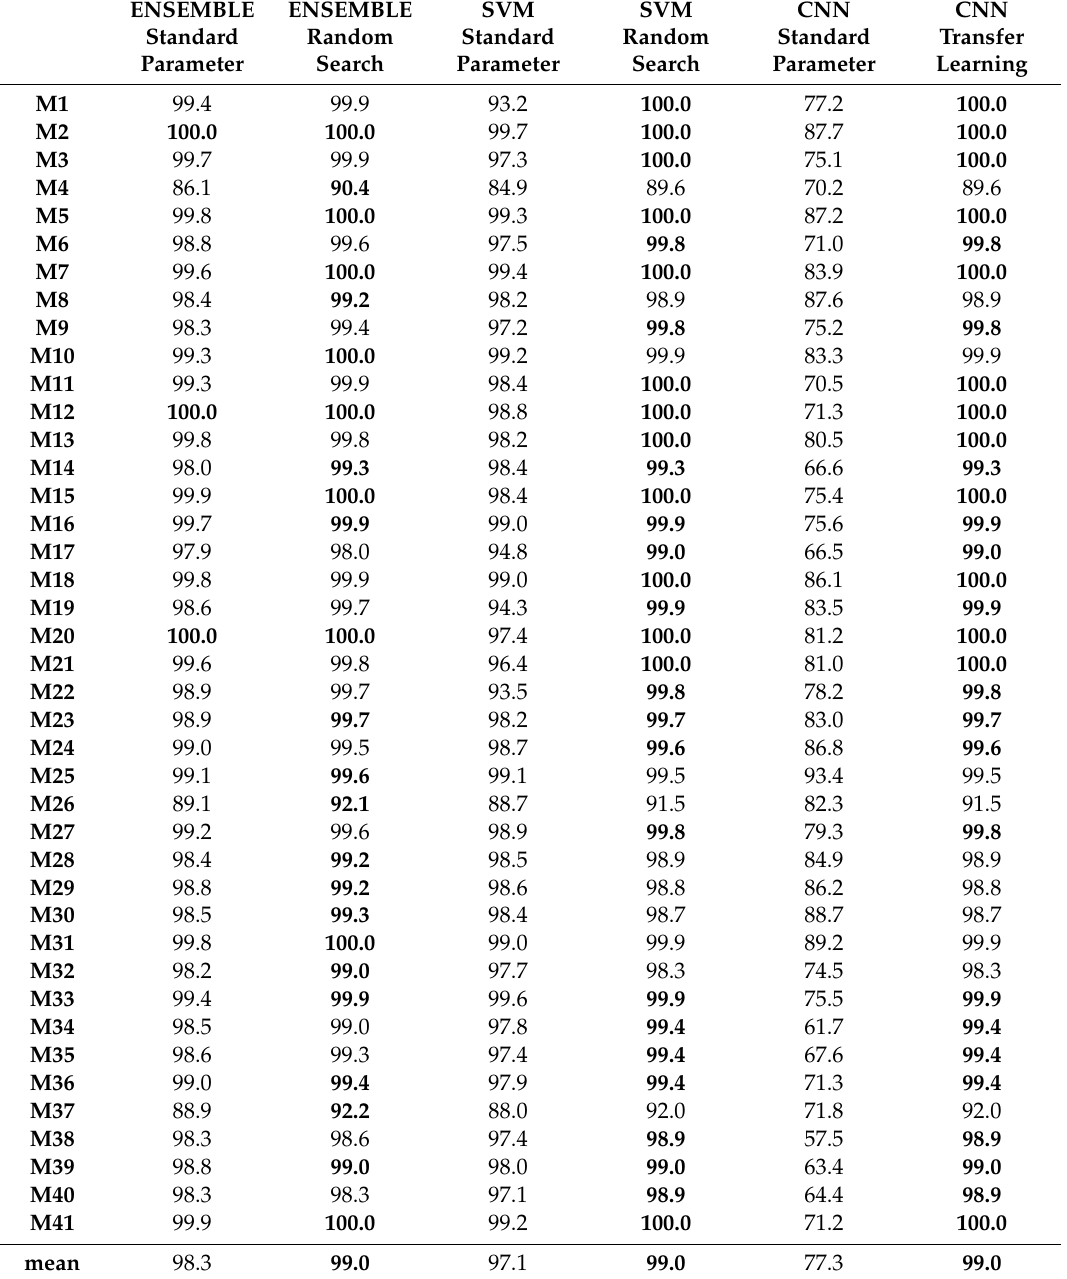
Table 2. Results of the classification attempts of the 41 individual models considered. The highest overall classification accuracy is shown in bold. For reasons of clarity, the confidence interval of the tests is not shown. Only the overall accuracy is shown because the results for the kappa coe ffi cient are very